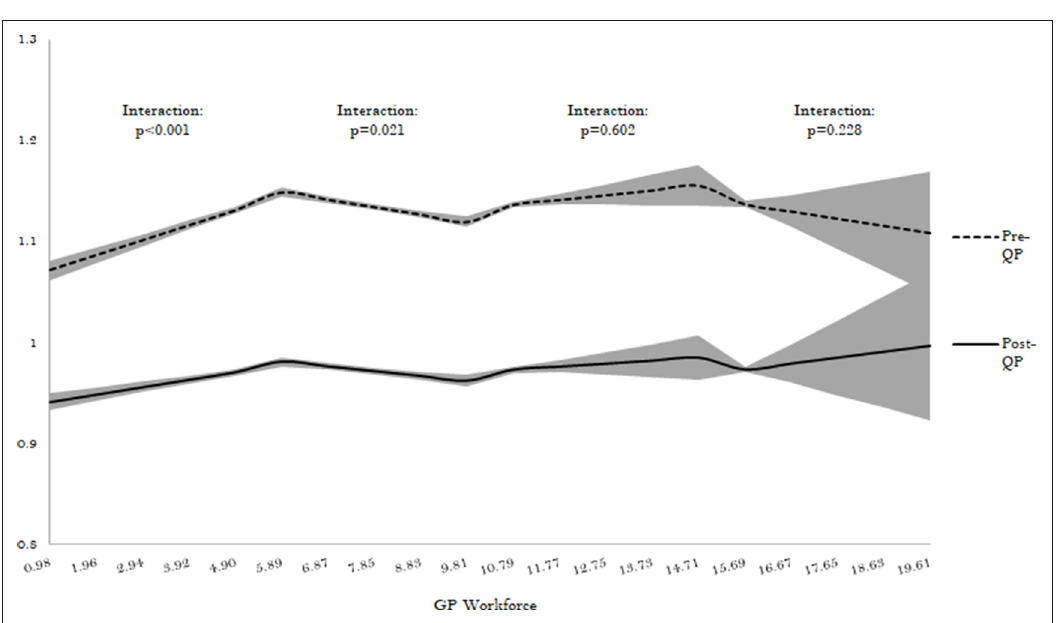
Figure 3 Association between GP workforce and antibiotic prescribing before and after the 2015–2016 QP (for workforce spline terms). The shaded portion around the line represents the 95% CI. QP = Quality